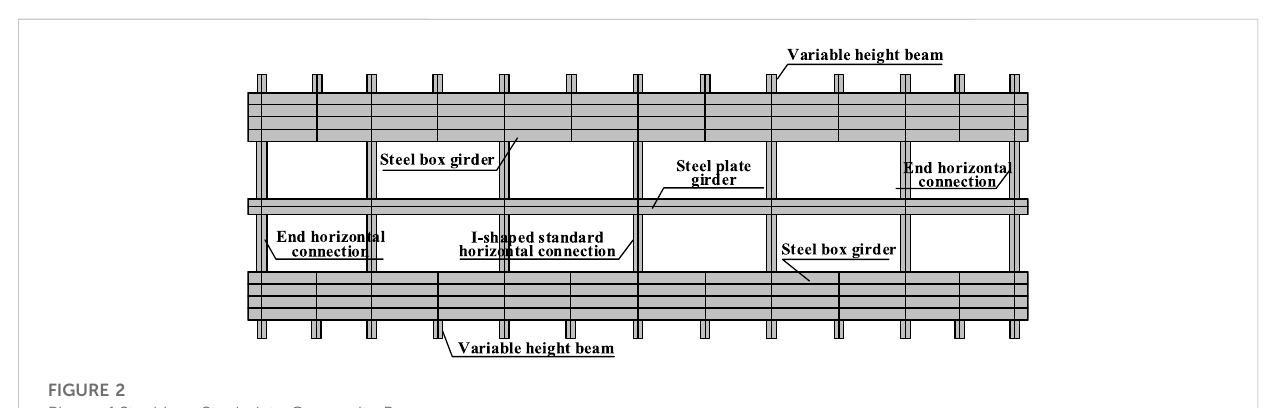
Plane of Steel box-Steel plate Composite